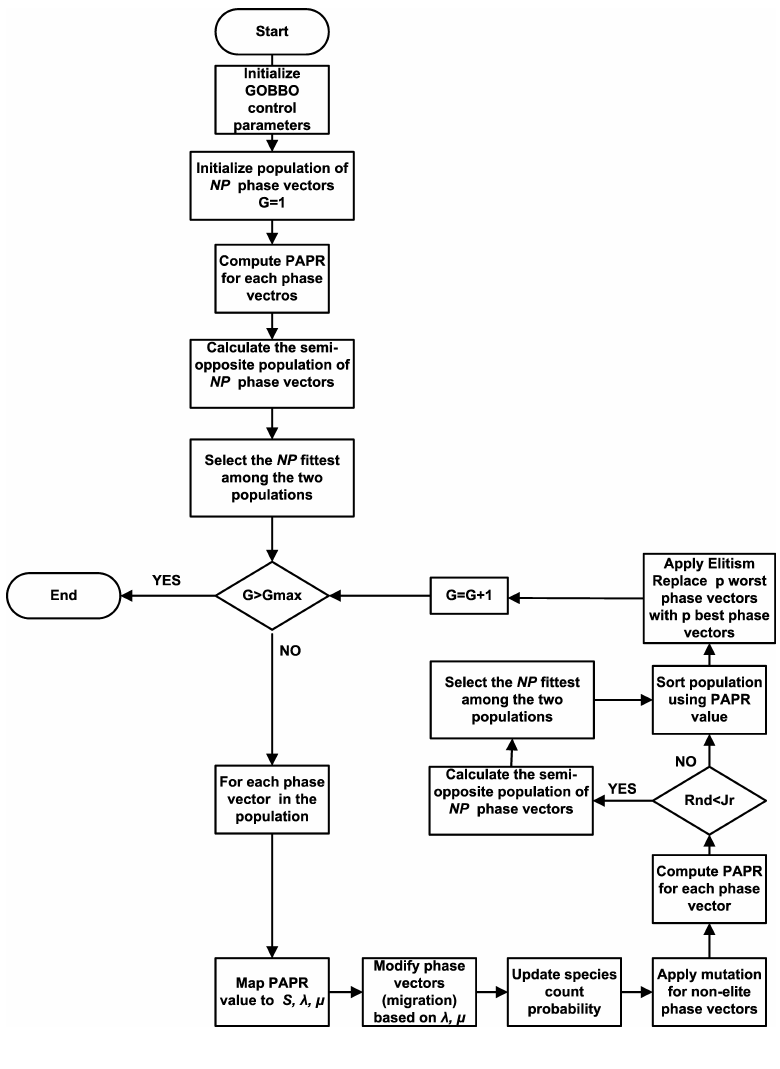
Fig. 1. GOBBO-PTS